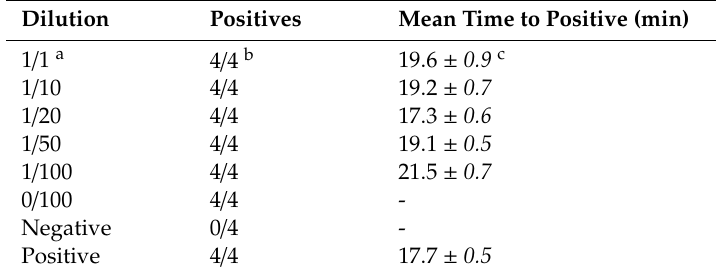
Table 1. Detection of green peach aphids (GPA; Myzus persicae ) individually or combined with